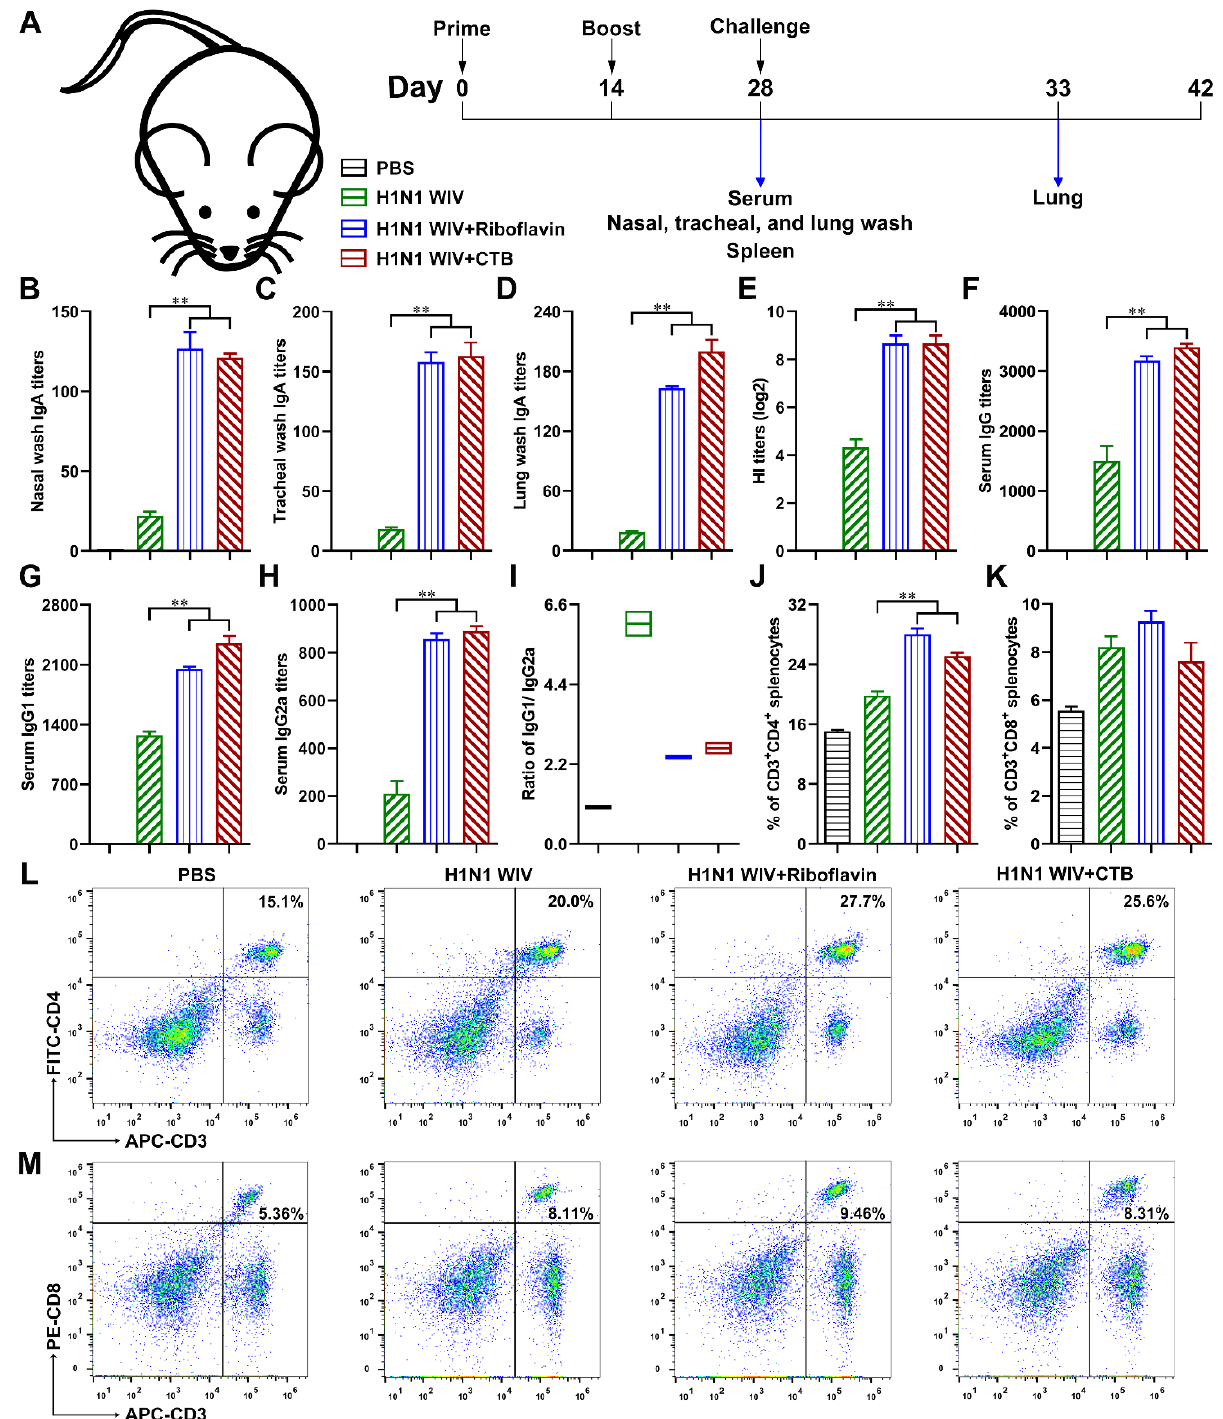
Figure 2. H1N1 WIV-specific local mucosal and systemic immunity after the intranasal immunization of mice. ( A ) Scheme of immunization ( n = 10/group), challenge, and sampling. ( B – D ) Twenty-eight days after the primary immunization, antigen-specific mucosa sIgA titers in the nasal wash ( B ), tracheal wash ( C ), and lung wash ( D ) of immunized mice were measured by ELISA. ( E ) Serum hemagglutination inhibition (HI) titers of immunized mice were measured by the HI assay. ( F – H ) Antigen-specific serum IgG titers ( F ), IgG1 titers ( G ), and IgG2a titers ( H ) of immunized mice were measured by ELISA. ( I ) The ratio of IgG1/IgG2a. ( J – M ) The percentages of CD3 + CD4 + ( J , L ) and CD3 + CD8 + ( K , M ) splenic T cells of immunized mice were analyzed via FCM. All of the data are presented as the mean ± SD. Statistical significance was assessed by one-way ANOVA to compare the results between different groups; ** p < 0.01.